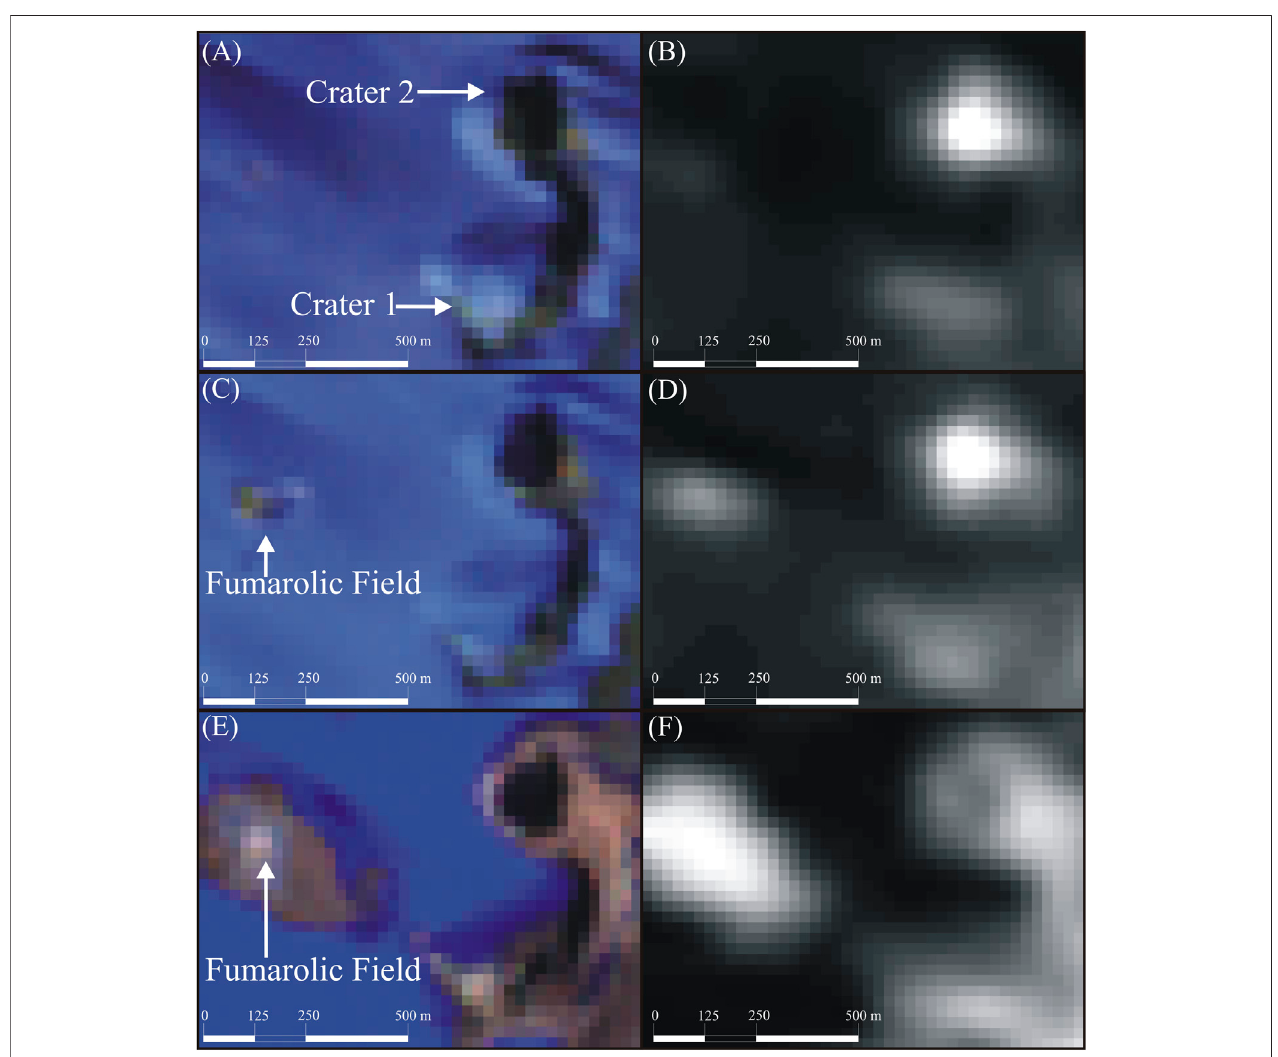
FIGURE2 | (A) Landsat TM (combination 754in RGB) showing Crater Lakes 1and 2(August17, 1986). (B) Landsat TM (TIR band) showing CraterLakes 1 and 2 (August 17, 1986). (C) Landsat TM (combination 754 in RGB) showing the new fumarolic fi eld, Crater Lakes 1 and 2 (August 18, 1986). (D) Landsat TM (TIR band) showing the new fumarolic fi eld, Crater Lakes 1 and 2 (September 18, 1986). (E) Landsat TM (combination 754 in RGB) showing an extended fumarolic fi eld, Crater Lakes 1 and 2 (January 10, 1991). (F) Landsat TM (TIR band) showing an extended fumarolic fi eld, Crater Lakes 1 and 2 (January 10, 1991).